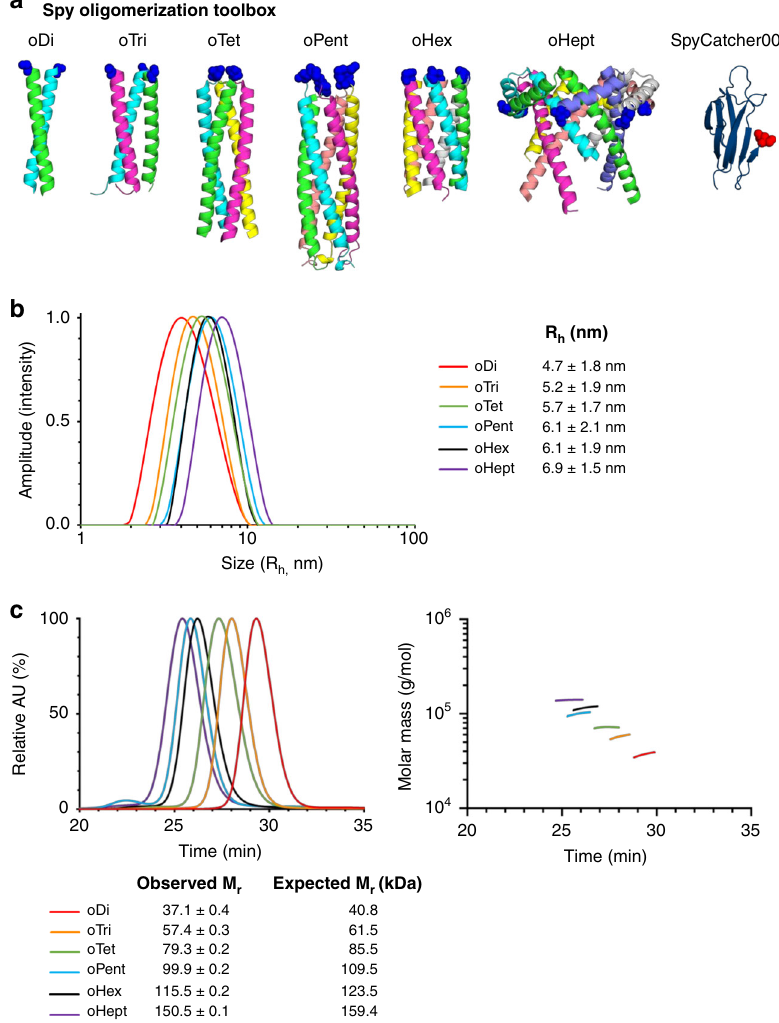
Fig. 6 Construction of oligomeric toolbox. a Spy Oligomerization Toolbox from establishing a panel of coiled coils with valency from 2 to 7 for fusion to SpyCatcher002. The coiled coils are presented with each color representing one chain and the N-terminus colored as a blue ball. The C-terminus of SpyCatcher002, where it will be linked to the coiled coil, is colored as a red ball. b DLS to show assembly of each SpyCatcher002-oligomer, with hydrodynamic radius ( R h ) (mean ± 1 s.d., n = 10) for each assembly. c SEC-MALS to show assembly of each SpyCatcher002-oligomer. The peak shows the normalized absorbance units (AU) at 280 nm of the SpyCatcher002-oligomer species from SEC. The horizontal line shows the distribution of molar mass (g/mol) of the species in the peak from MALS. Expected and observed molecular weight ( M r ) is shown alongside, with error bars representing the uncertainty in fi t to the molar mass